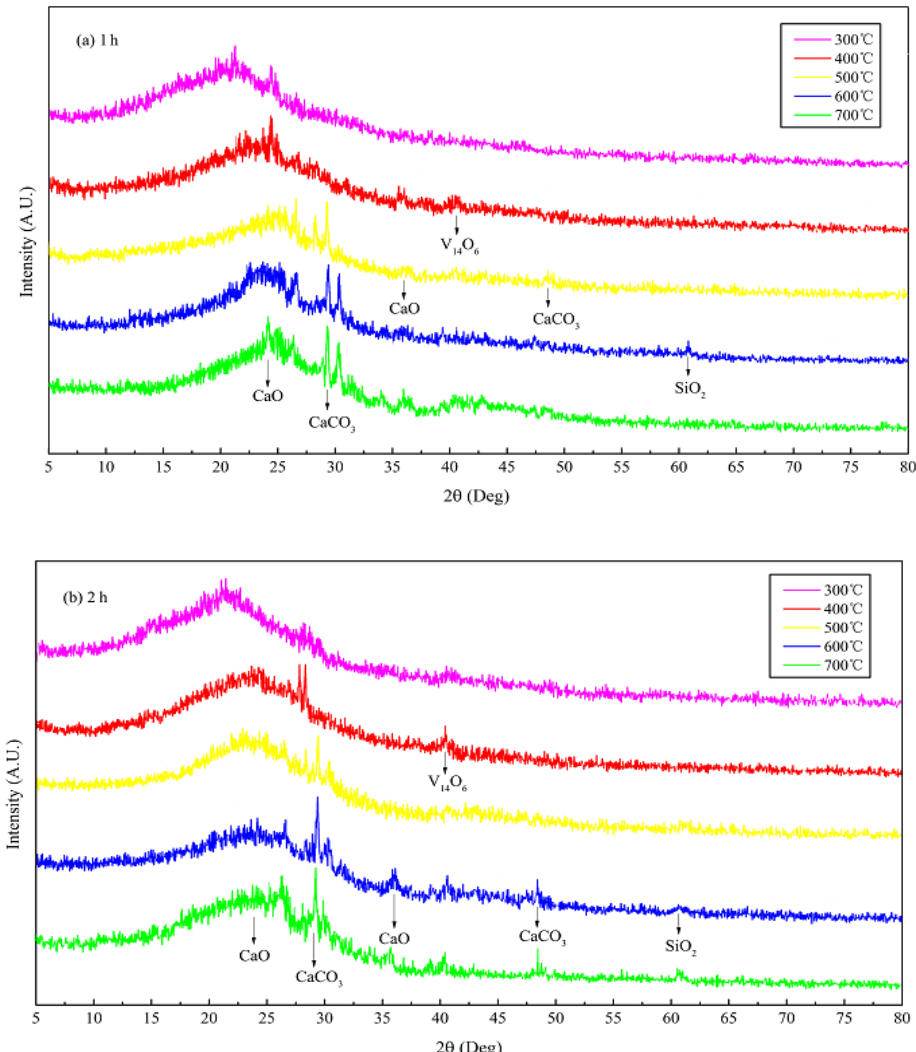
Figure 4. XRD patterns of JB under different carbonization conditions. ( a ) for 1 h; ( b ) for 2 h.